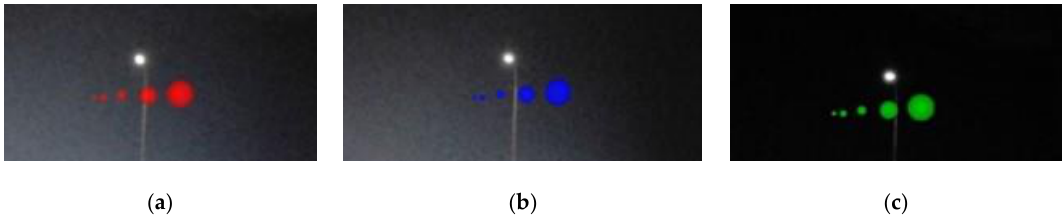
Figure 4. Matching spheres (size and luminosity) with the actual light at a distance of 150 m.